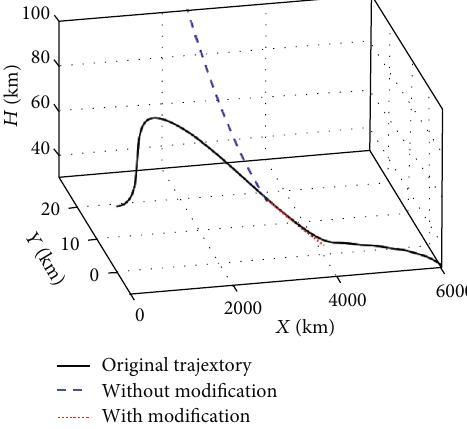
Figure 8: Comparison of predicted results with or without the start and last point modi fi cation